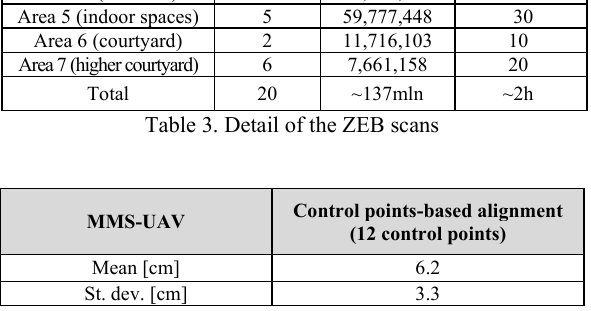
Table 4. Results of the ZEB data alignment